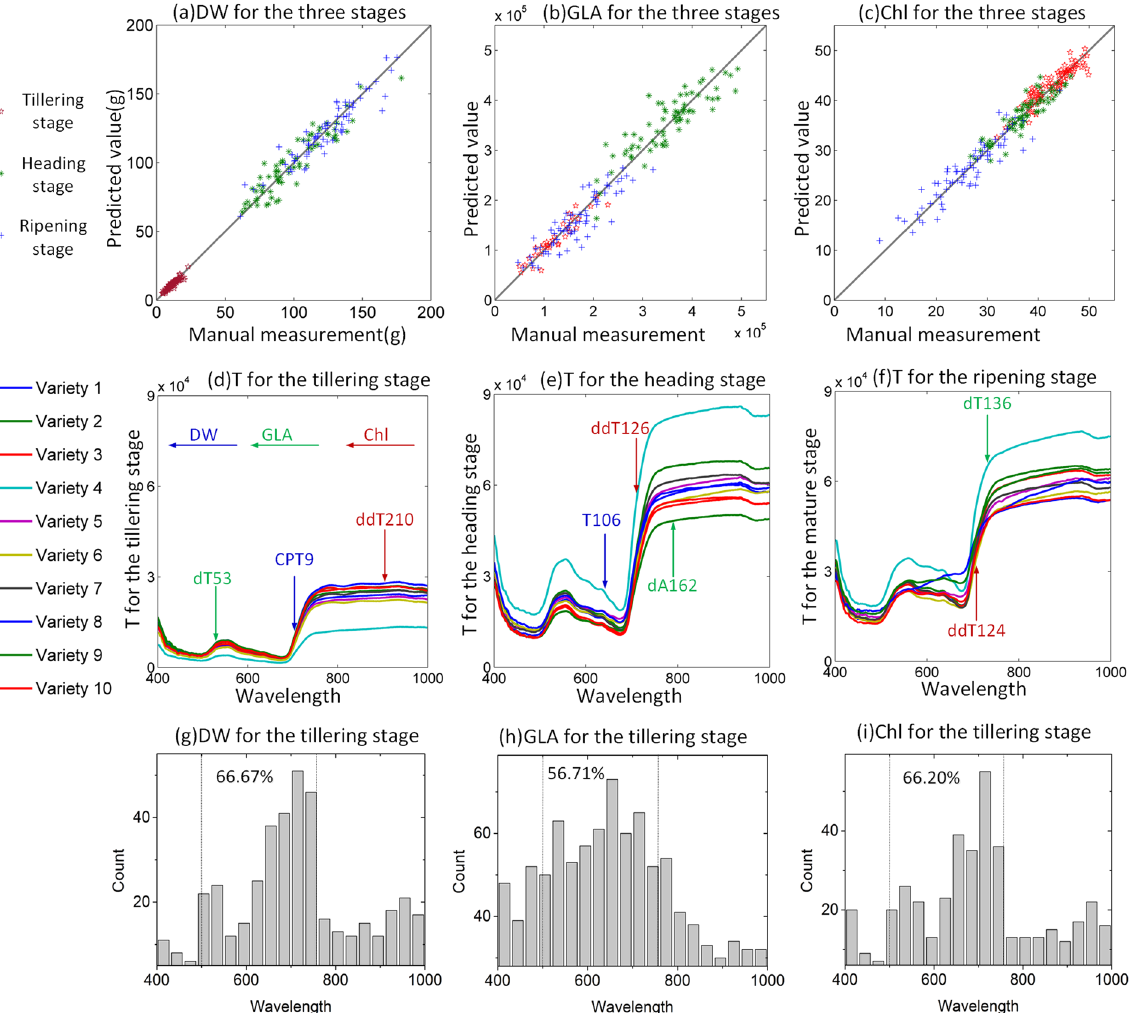
Figure 2. Performance of the LSR for the three growth stages. ( a ) Scatter plot of HHIS measurements versus manual measurements of DW for the three growth stages. ( b ) Scatter plot of HHIS measurements versus manual measurements of GLA for the three growth stages. ( c ) Scatter plot of HHIS measurements versus manual measurements of Chl for the three growth stages. ( d ) Total reflectance for the tillering stage. The blue arrow represents the important hyperspectral indices for DW, the green arrow represents the important hyperspectral indices for GLA, and the red arrow represents the important hyperspectral indices for Chl. ( e ) Total reflectance for the heading stage, with the same arrow coding as described above. ( f ) Total reflectance for the ripening stage, with the same arrow coding as described above. ( g ) The wavelength frequency distribution of the hyperspectral indices that had correlation coefficients with DW greater than 0.3 for the tillering stage. ( h ) The wavelength frequency distribution of the hyperspectral indices that had correlation coefficients with GLA greater than 0.3 for the tillering stage. ( i ) The wavelength frequency distribution of the hyperspectral indices that had correlation coefficients with Chl greater than 0.3 for the tillering